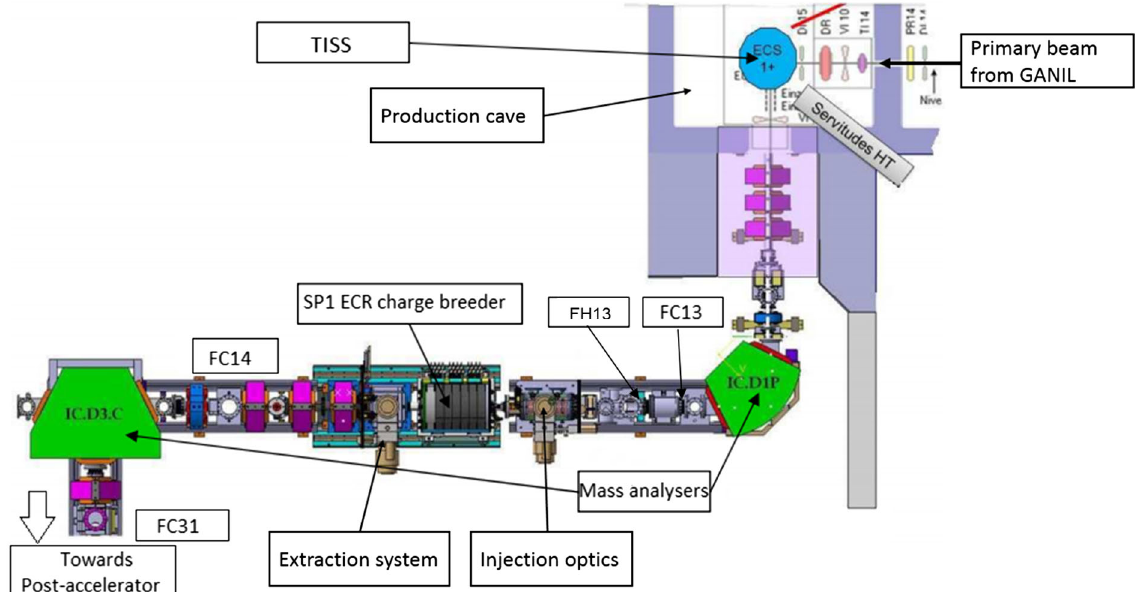
FIG. 1. Schematic layout of the experimental setup at SPIRAL1 facility.